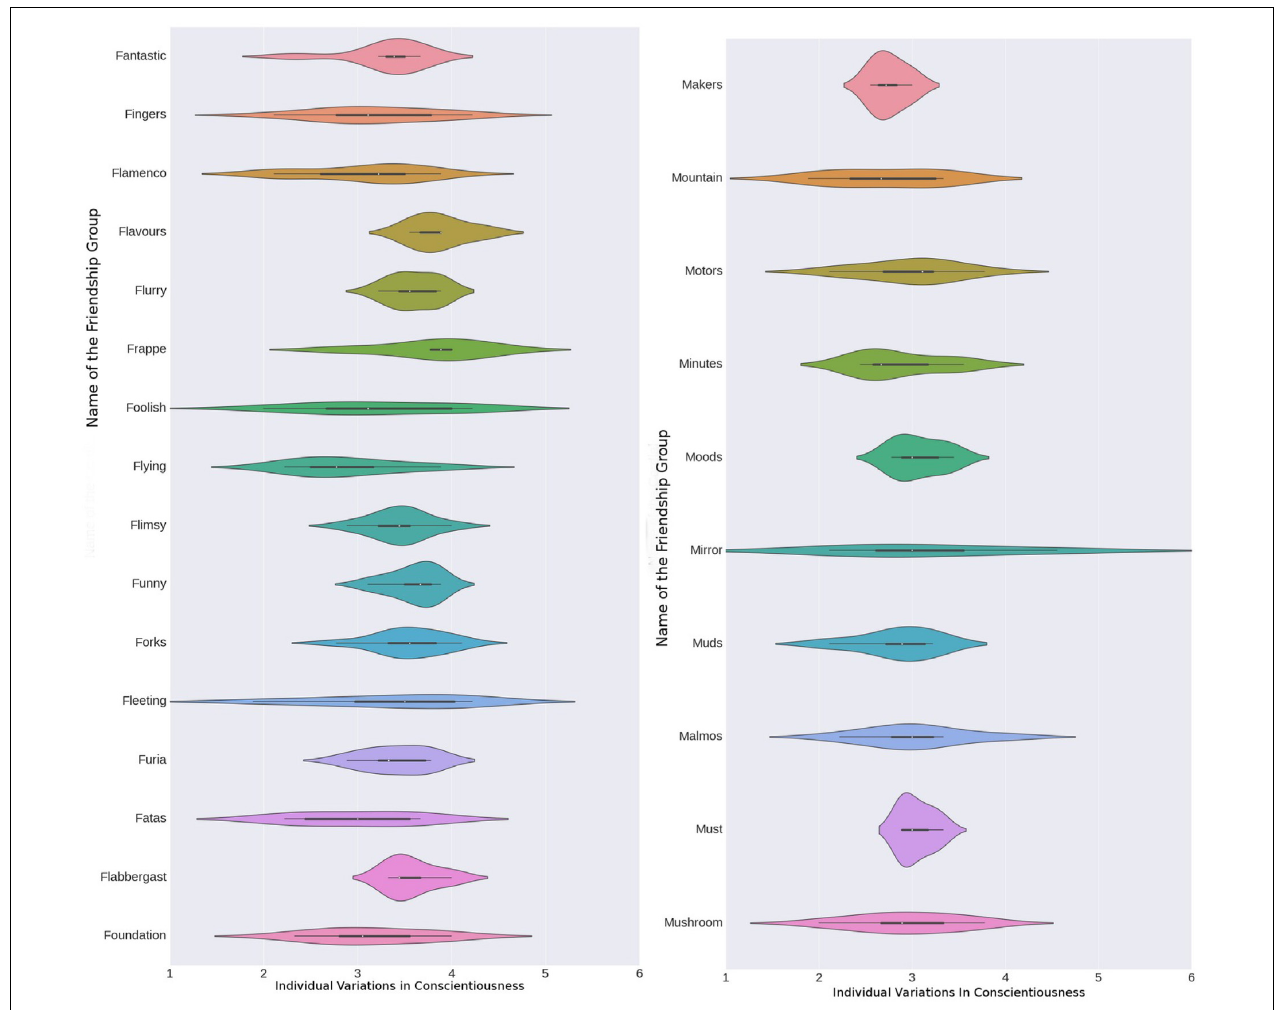
FIGURE 1 | Variations in Conscientiousness for friendship groups, standard deviations for female groups ( left , N = 16) and 10 male groups ( right , N = 10).